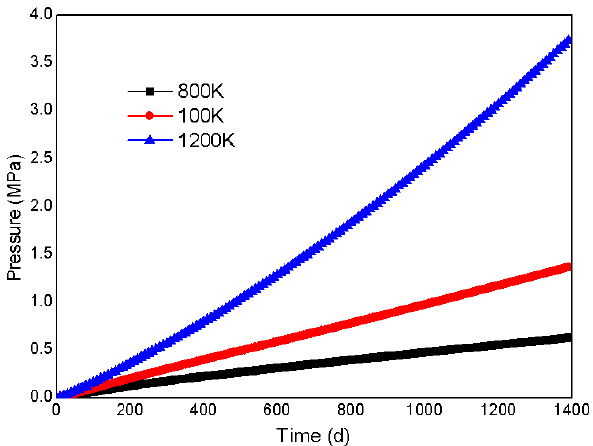
Figure 7. Fission gas pressure inside the TRISO particle throughout its life time.